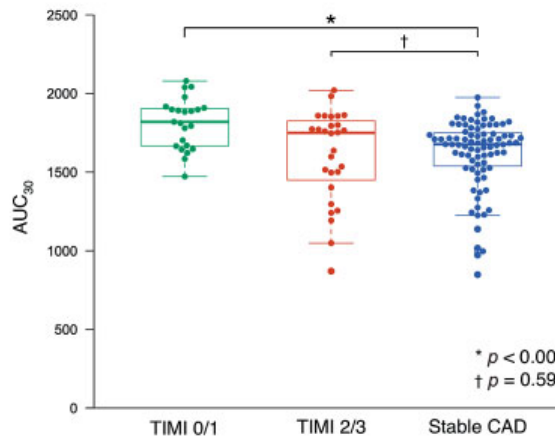
Fig. 1 Comparison of blood thrombogenicity between acute MI and stable CAD. Patients with acute MI had signi fi cantly higher AUC 30 levels than those with stable CAD (1,771 [1,585 – 1,884] vs. 1,677